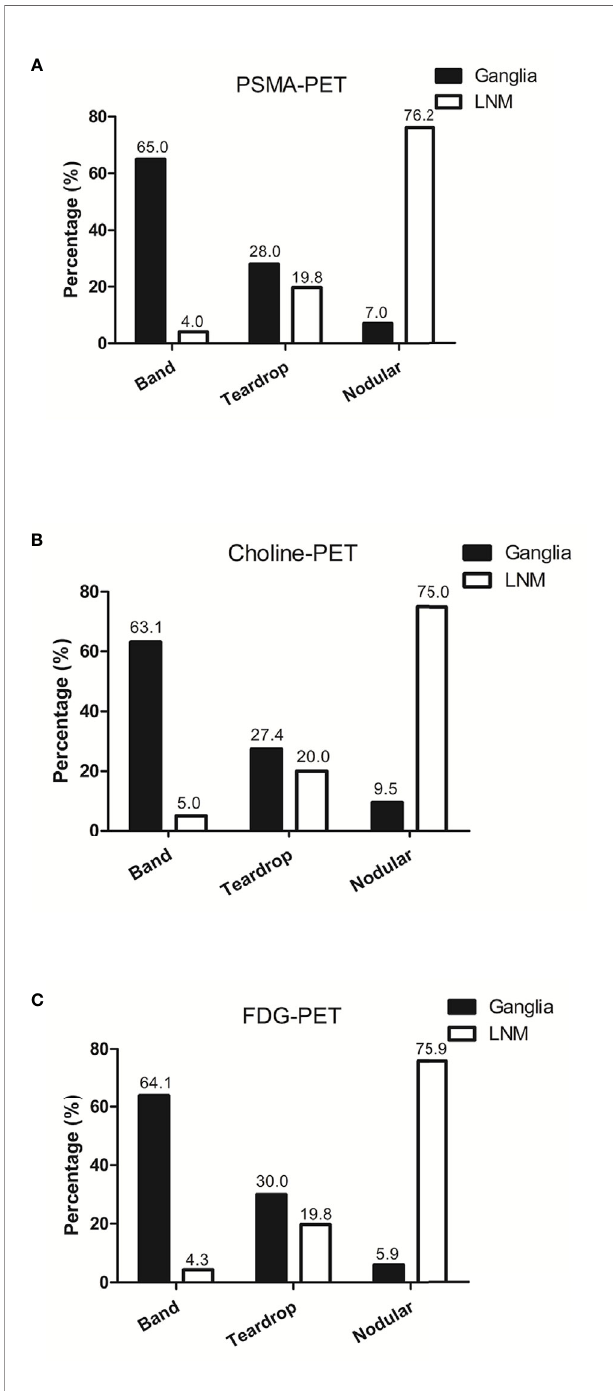
FIGURE 6 | The anatomic morphology of ganglia and LNM in PSMA-PET, choline-PET and FDG-PET. (A) The anatomic morphology of ganglia and LNM in PSMA-PET. (B) The anatomic morphology of ganglia and LNM in choline-PET. (C) The anatomic morphology of ganglia and LNM in